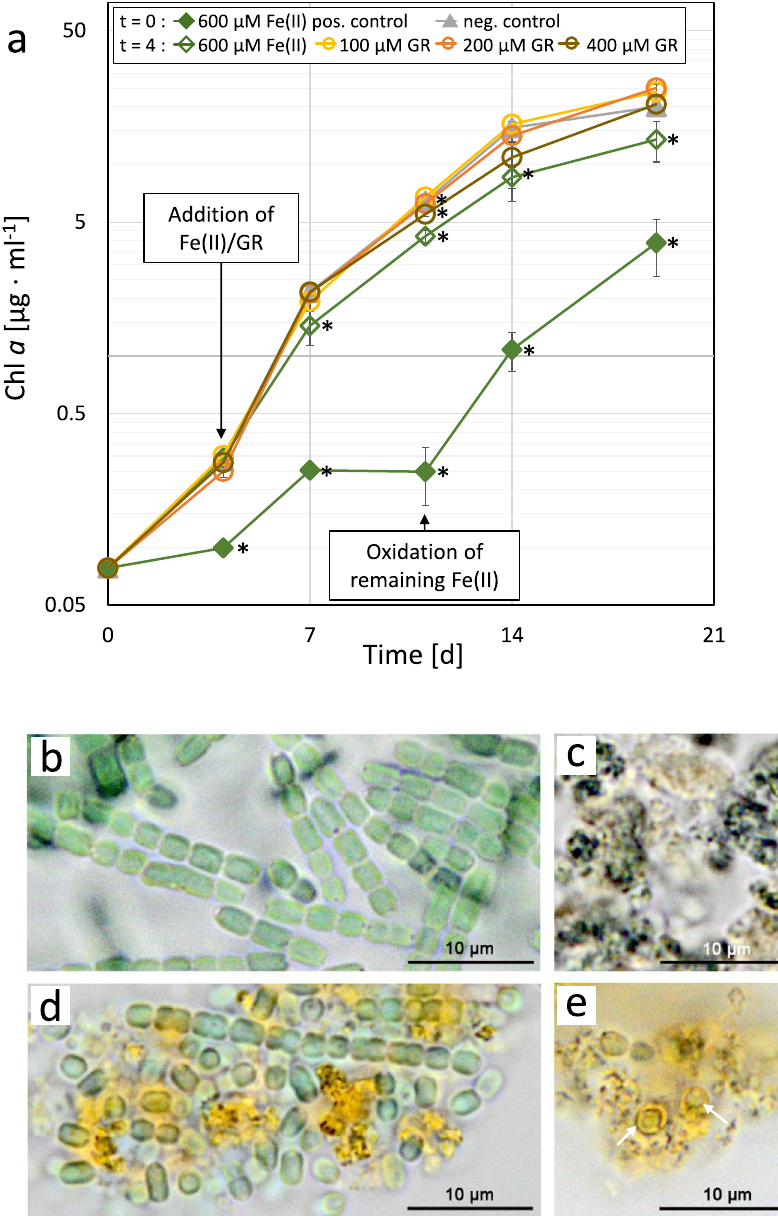
Fig. 4 Illustration of the effect of green rust on the growth of Pseudanabaena sp. PCC7367. The Chl a growth ( a ) and light microscopic pictures ( b , d , e ) of Pseudanabaena sp. PCC7367 cultures after the addition of Fe(II) or green rust (GR, c ). Chl a growth curves ( a ) of cultures in an anoxic open-culture system with the addition of 600 µ M Fe(II) (open, green), 100 µ M GR (open, yellow), 200 µ M GR (open, orange) or 400 µ M GR (open brown) on day 4 of exponential growth. The positive control had 600 µ M Fe(II) added at the start of the experiment (closed, green), while the negative control had no addition of Fe (closed, grey). On day 6, 2 days after the addition of Fe(II)/GR, light microscopic pictures were taken of the negative control culture ( b ), the GR in an abiotic control ( c ), the culture with the addition of 400 µ M GR on day 4 ( d ) and the positive control with 600 µ M Fe(II) at the start of the experiment ( e ). On day 9, the remaining Fe(II)/GR in the positive control was oxidised by exposure to oxic ambient air for 10 min. Data are presented as mean values ± SD with n = 3 biologically independent samples. Light microscopic images were taken at 100x magni fi cation and are presented with a 10 µ m scale bar. Asterisks (*) represent a signi fi cant difference between Fe(II)/GR supplemented cultures and the growth control ( p < 0.05, Student ’ s t -test,